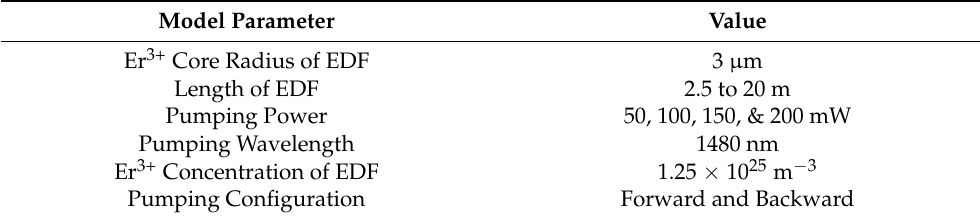
Table 3. Typical parameters of the rate equation model EDFA in VPI.